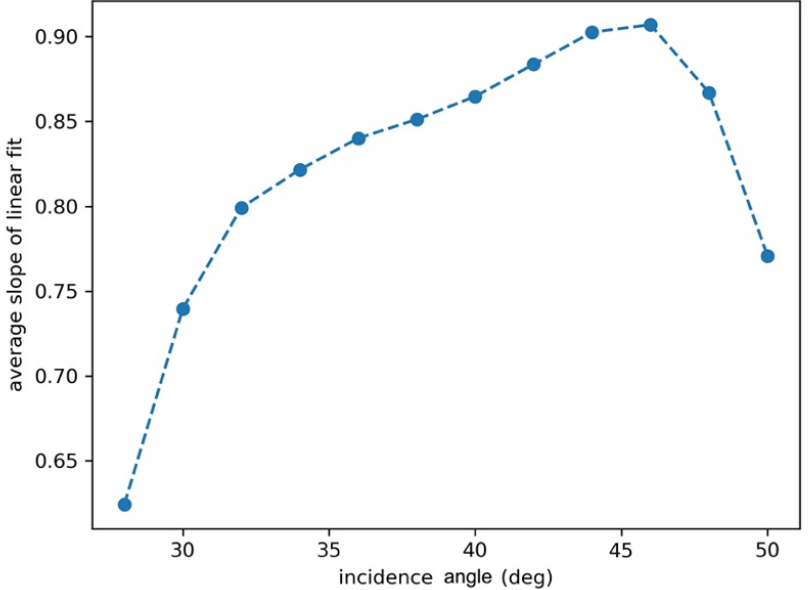
Figure 5. The average slopes from Jan to March in the Arctic as a function of incidence angle (trun- cated_inc).